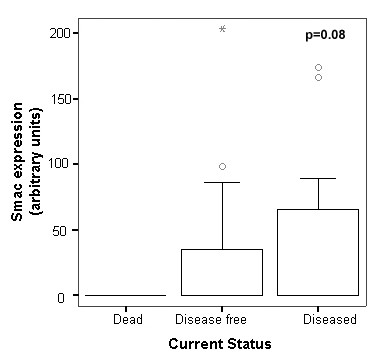
Smac expression versus disease status of cervical cancer samples. Graph shows median, upper and lower quartiles. P value testing the significance of the difference by ANOVA.